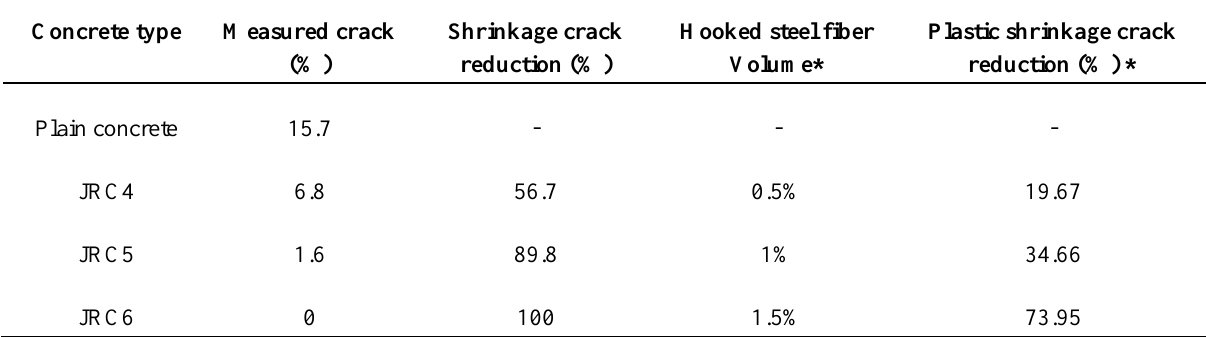
Fig. 8. Image analysis for shrinkage crack (area covered 48 in 2 ). Shrinkage test